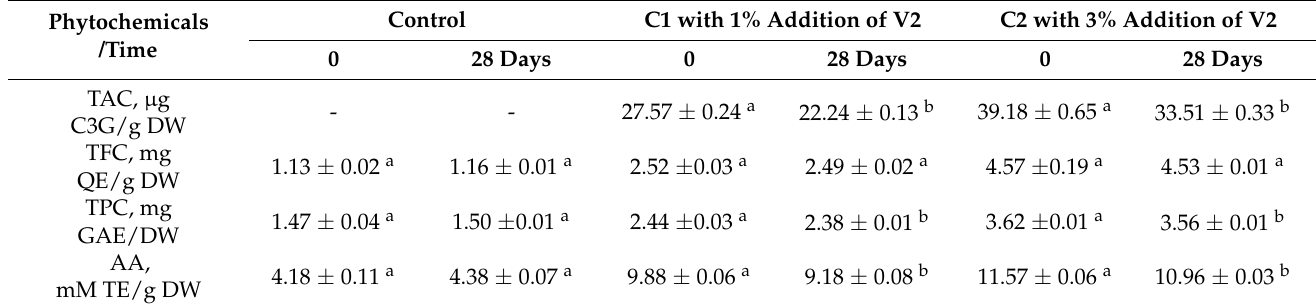
Table 3. Phytochemical characteristics of added-value crackers and stability during 28 days of